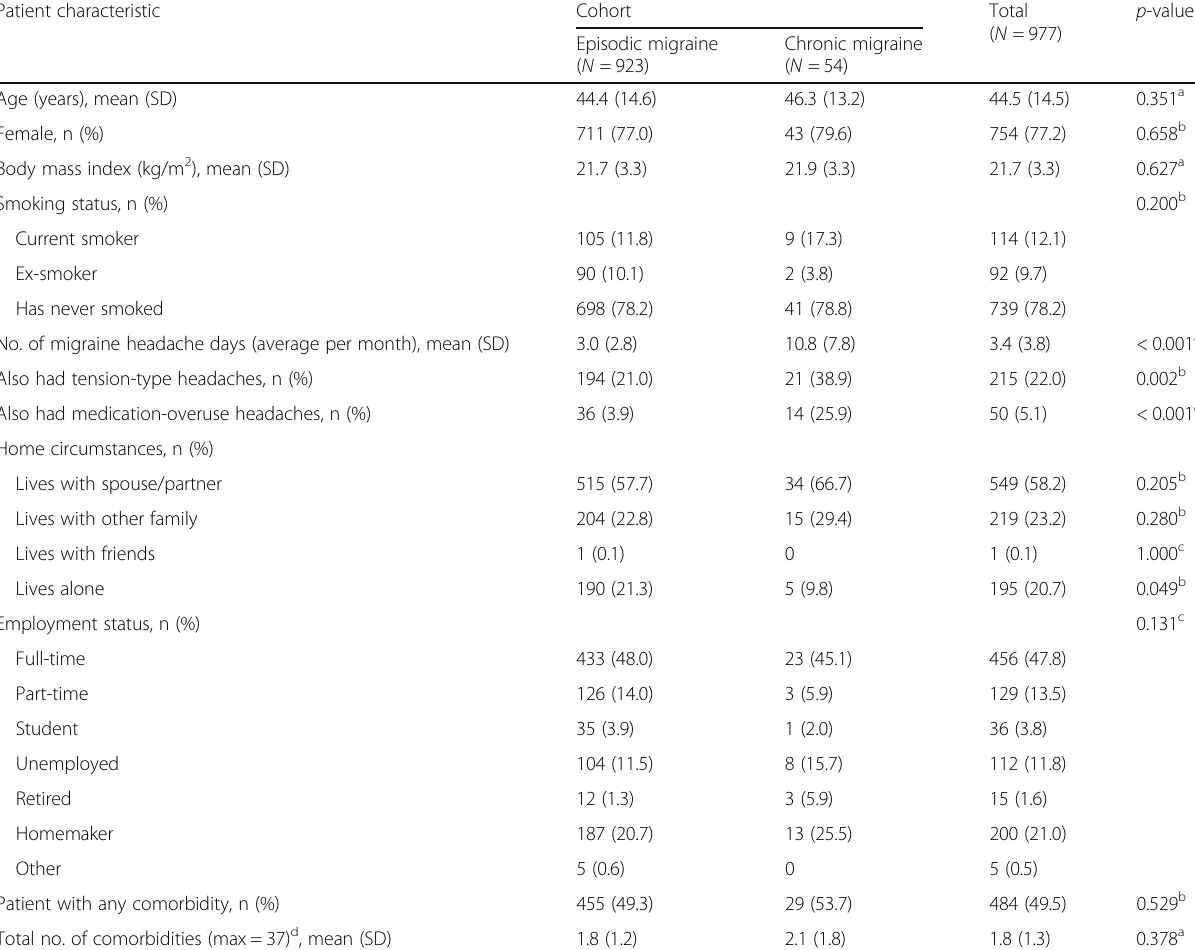
Table 1 Characteristics of patients with episodic migraine and chronic migraine: physician-reported data Patient